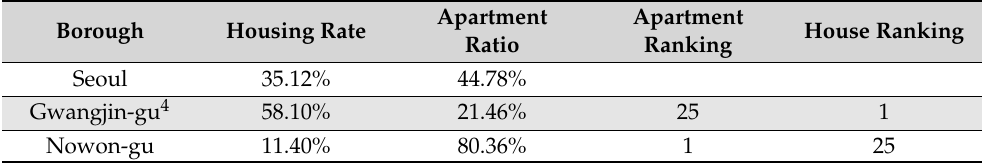
Table 2. Housing types in Seoul (City of Seoul